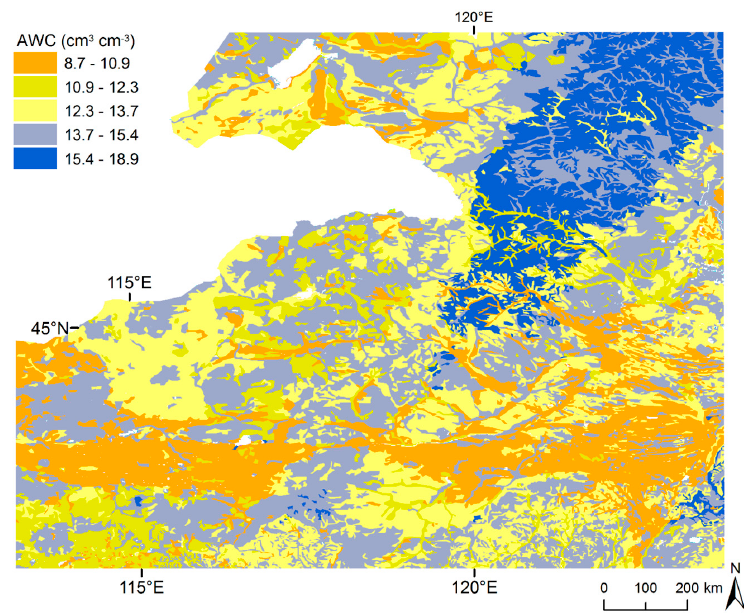
Figure 4. Map of Available Water Capacity (AWC) in (cm 3 ·cm − 3 ) of the study region in northeastern China (data from Dai et al. (2013) [44]).